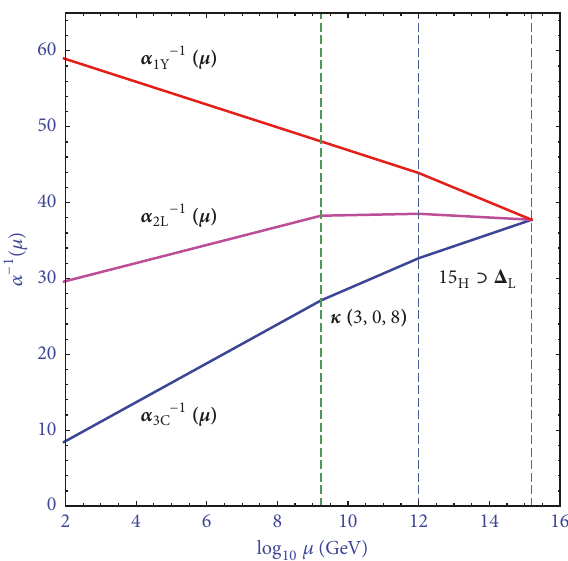
Figure 7: Unification of SM gauge couplings in the presence of 𝜅(3, 0, 8) at 𝑀 = 10 9.23 GeV and 15 ⊂ 𝑆𝑈(5) at 𝑀 = 10 12 휅 퐻 15 GeV as discussed in the text. The vertical dashed lines represent the intermediate scale masses and GUT